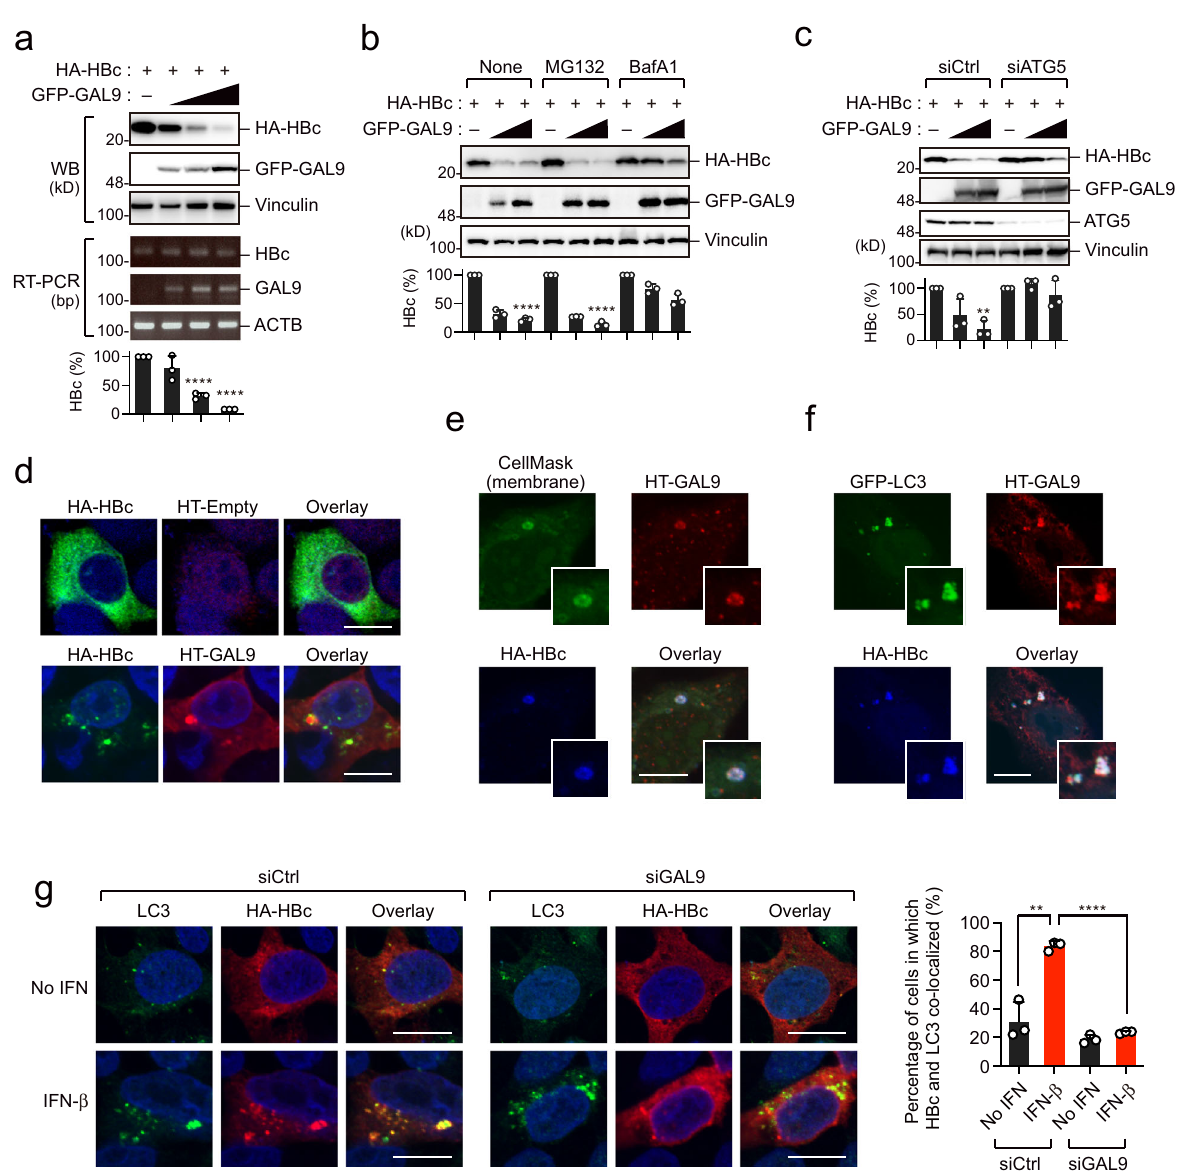
Fig. 2 GAL9 leads to the autophagic degradation of HBc. a GAL9 decreases the level of HBc protein. Immunoblotting (upper) and RT-PCR assays (lower) of HepG2 cells expressing HA-HBc and GFP-GAL9. b Ba fi lomycin A1 inhibits GAL9-induced HBc degradation. HepG2 cells were transfected with vectors encoding HA-HBc and GFP-GAL9. Cells were treated with ba fi lomycin A1 (BafA1, 100 µ M) or MG132 (10 µ M) 16 h prior to harvesting. c ATG5 depletion attenuates GAL9-induced HBc degradation. HepG2 transduced with control- (Ctrl) or ATG5-targeting siRNA were transfected with vectors encoding HA- HBc and GFP-GAL9. d GAL9 and HBc accumulation in cytoplasmic bodies. Confocal microscopic imaging of HepG2 cells expressing HA-HBc and HaloTag empty vector (upper) or HaloTag-GAL9 (lower). Nuclei were stained with DAPI. Scale bar, 10 µ m. Another view of the cell image is shown in Supplementary Fig. 2a. e GAL9 and HBc accumulation in intracellular membranes. Confocal micrographs show HepG2 cells expressing HA-HBc and HaloTag-GAL9. Intracellular membranes were stained with CellMask reagent. Expanded views are also shown. Scale bar, 10 µ m. Another view of the cell image is shown in Supplementary Fig. 2b. f GAL9 and HBc co-localize with LC3. Confocal micrographs show HepG2 cells expressing HT-GAL9, HA-HBc, and GFP-LC3. Expanded views are also shown. Scale bar, 10 µ m. Another view of the cell image is shown in Supplementary Fig. 2c. g IFN- β increases colocalization of HBc and LC3 in a GAL9-dependent manner. Confocal micrographs show HepG2 cells expressing HA-HBc in the presence or absence of IFN- β . Scale bar, 10 µ m. Another view of the cell image is shown in Supplementary Fig. 2f. The graph on the right shows the percentage of cells in which HBc localized to LC3-positive puncta ( n = 50 cells examined over three experiments, mean ± SD). ** P = 0.0027, **** P < 0.0001, two-tailed unpaired t -test. Scale bar, 10 µ m. Bar charts in a – c indicate the ratio of HBc over Vinculin, as determined by densitometry, and are presented as a mean ± SD ( n = 3 experiments). **** P < 0.0001 ( a , b ), ** P = 0.0011 ( c ), two-tailed unpaired t -test. Immunoblots and micrographs are representative of experiments with similar results ( n ≥ 2). Source data are provided as a Source Data fi